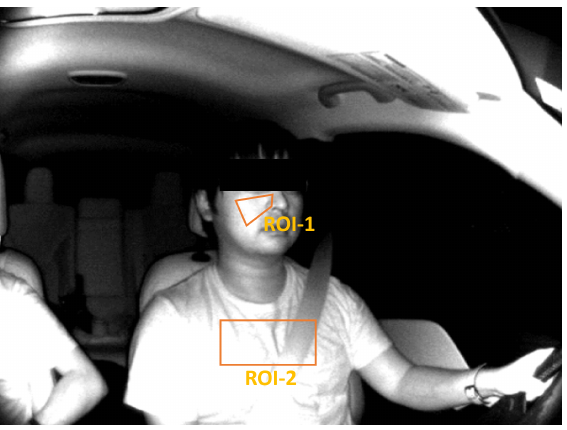
Figure 2. Position of both ROI-1 and ROI-2 as seen by the ToF camera. The grayscale intensity and depth information from ROI-1 are used for HR measurement, and the depth information from ROI-2 is used for RR